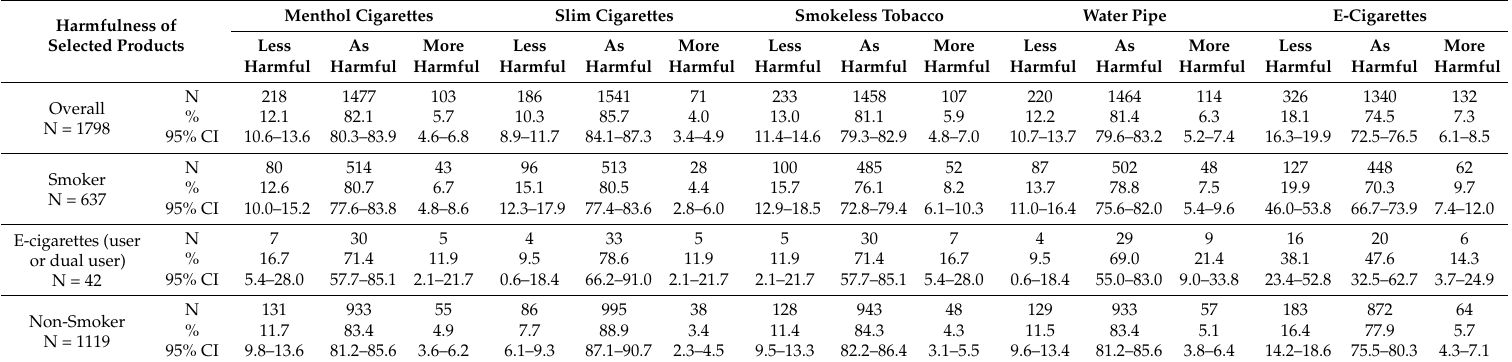
Table 1. Perceived harmfulness of tobacco/nicotine